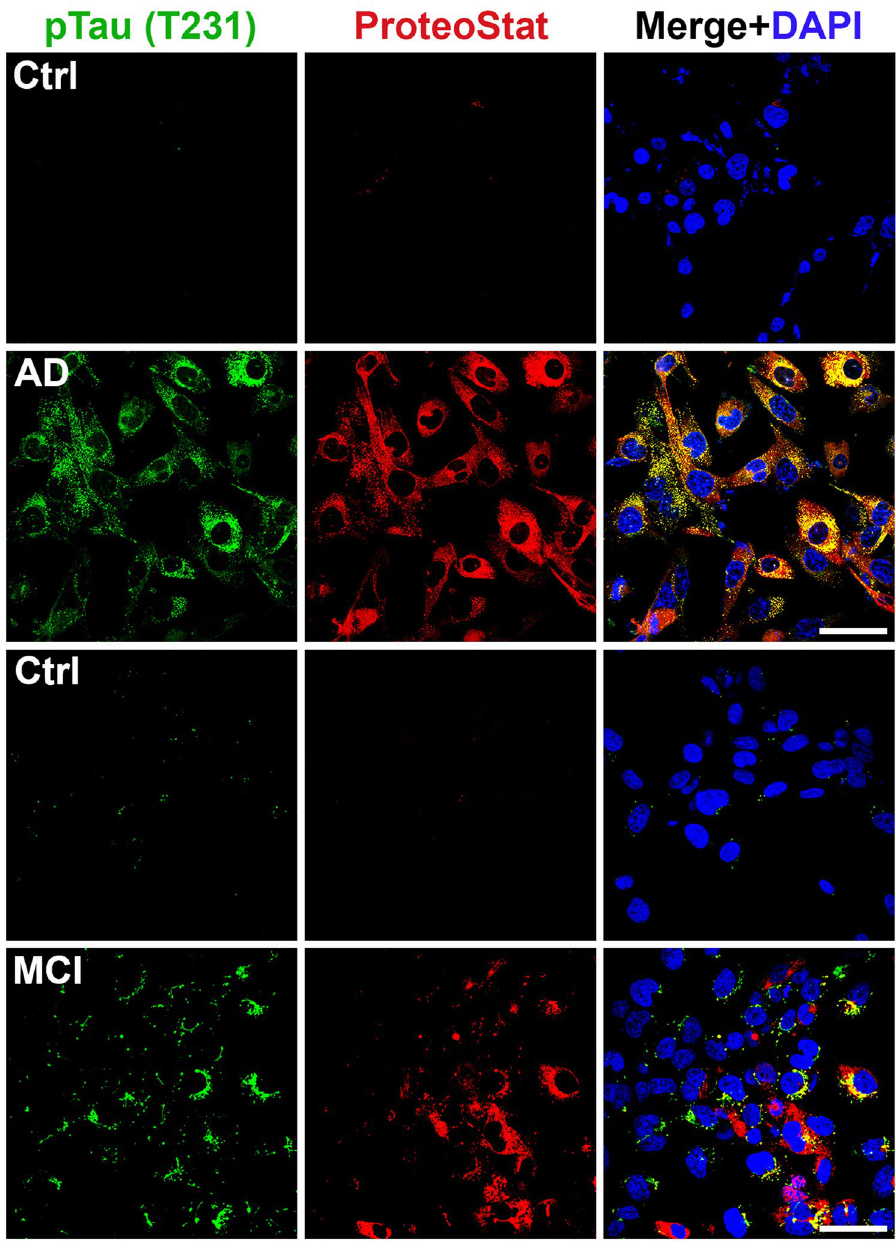
specific anti-phosphorylated Tau (T231) antibody and co-stained with ProteoStat dye. Images are representatives of at least 3 independent experiments. Bar: 50